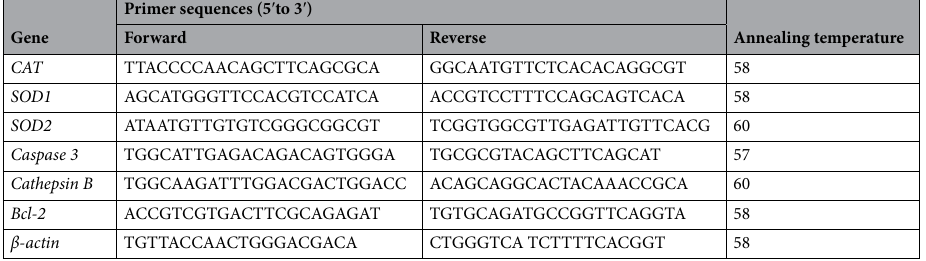
Table 2. Primer sequences for quantitative real-time PCR. CAT, catalase; SOD1, superoxide dismutase 1; SOD2, superoxide dismutase 2; and Bcl-2, B-cell